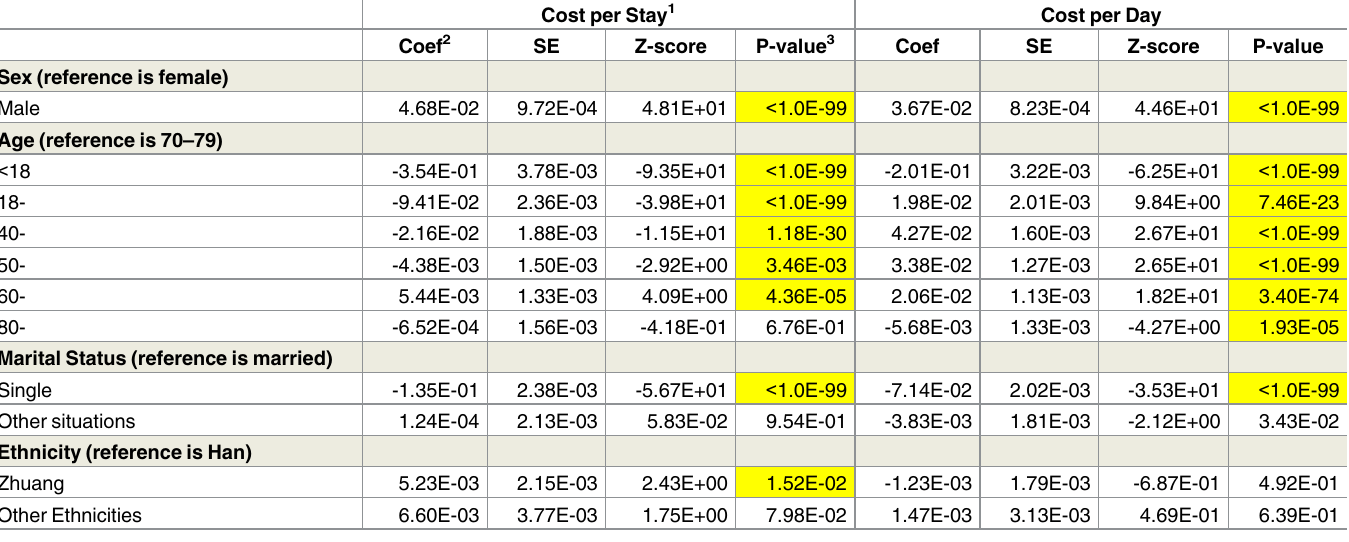
Table 2. Assessing associations of cost per stay and cost per day with sex, age, marital status, and ethnicity through estimating coefficient, stan- dard error, Z- score and P-value, with an adjustment across all 141 hospitals and 4 calendar years.